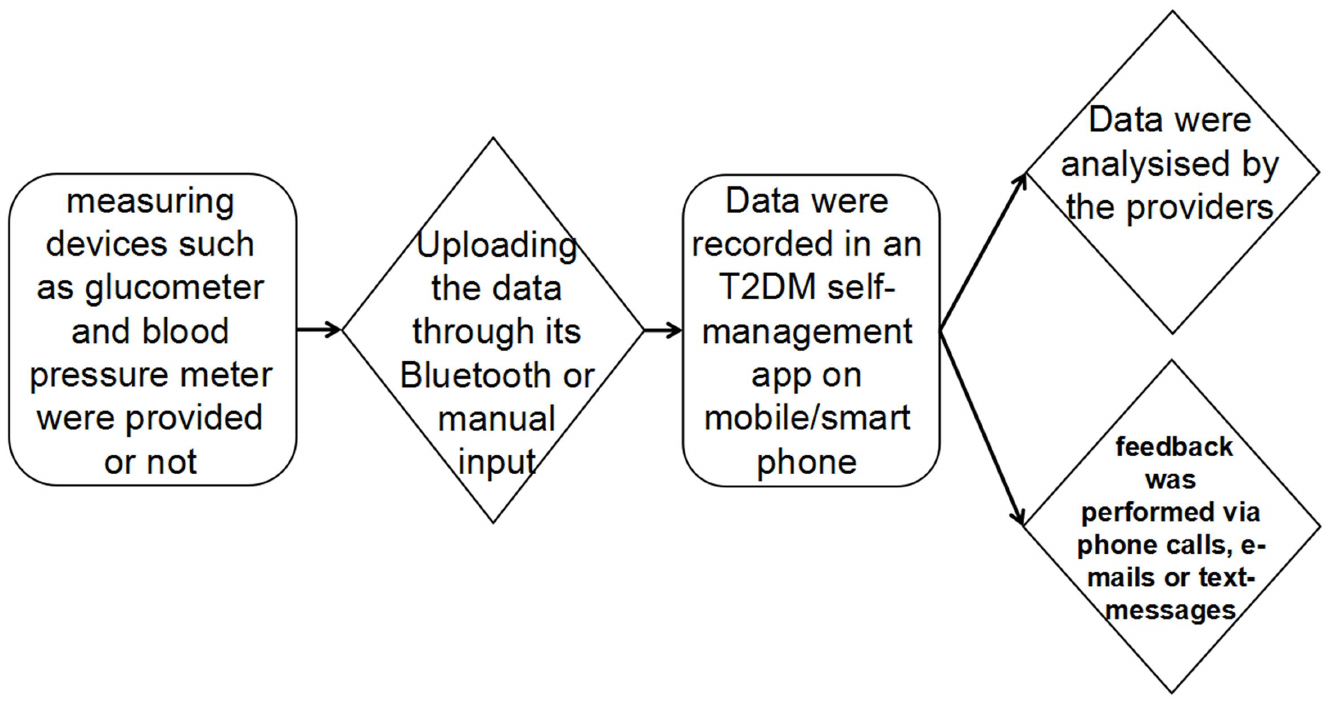
Fig 2. A model to demonstrate how self-management apps work.